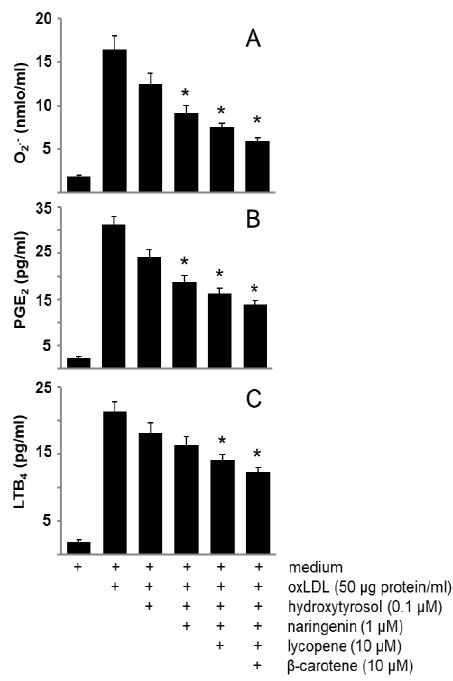
Figure 3. E ff ects of bioactive compounds of sofrito on O 2 − , PGE 2 and LTB 4 production stimulated Figure 3. Effects of bioactive compounds of sofrito on O 2.- , PGE 2 and LTB 4 production stimulated by by oxLDL. Macrophages were incubated with hydroxytyrosol (0.1 µ M), naringenin (1 µ M), lycopene oxLDL. Macrophages were incubated with hydroxytyrosol (0.1 µM), naringenin (1 µM), lycopene (10 (10 µ M) or β -carotene (10 µ M) for 30 min, and then stimulated with oxLDL (50 µ g protein / mL) μM) or β-carotene (10 µM) for 30 min, and then stimulated with oxLDL (50 µg protein/mL) for 30 for 30 min. Finally, O 2 − ( A ), PGE 2 ( B ) or LTB 4 ( C ) were measured. Data are the means ± SEM min. Finally, O 2.- ( A ), PGE 2 ( B ) or LTB 4 ( C ) were measured. Data are the means ± SEM of three of three experiments performed in triplicate. * Significantly di ff erent ( p < 0.05) with respect to experiments performed in triplicate. * Significantly different ( p < 0.05) with respect to oxLDL- oxLDL-stimulated stimulated macrophages.